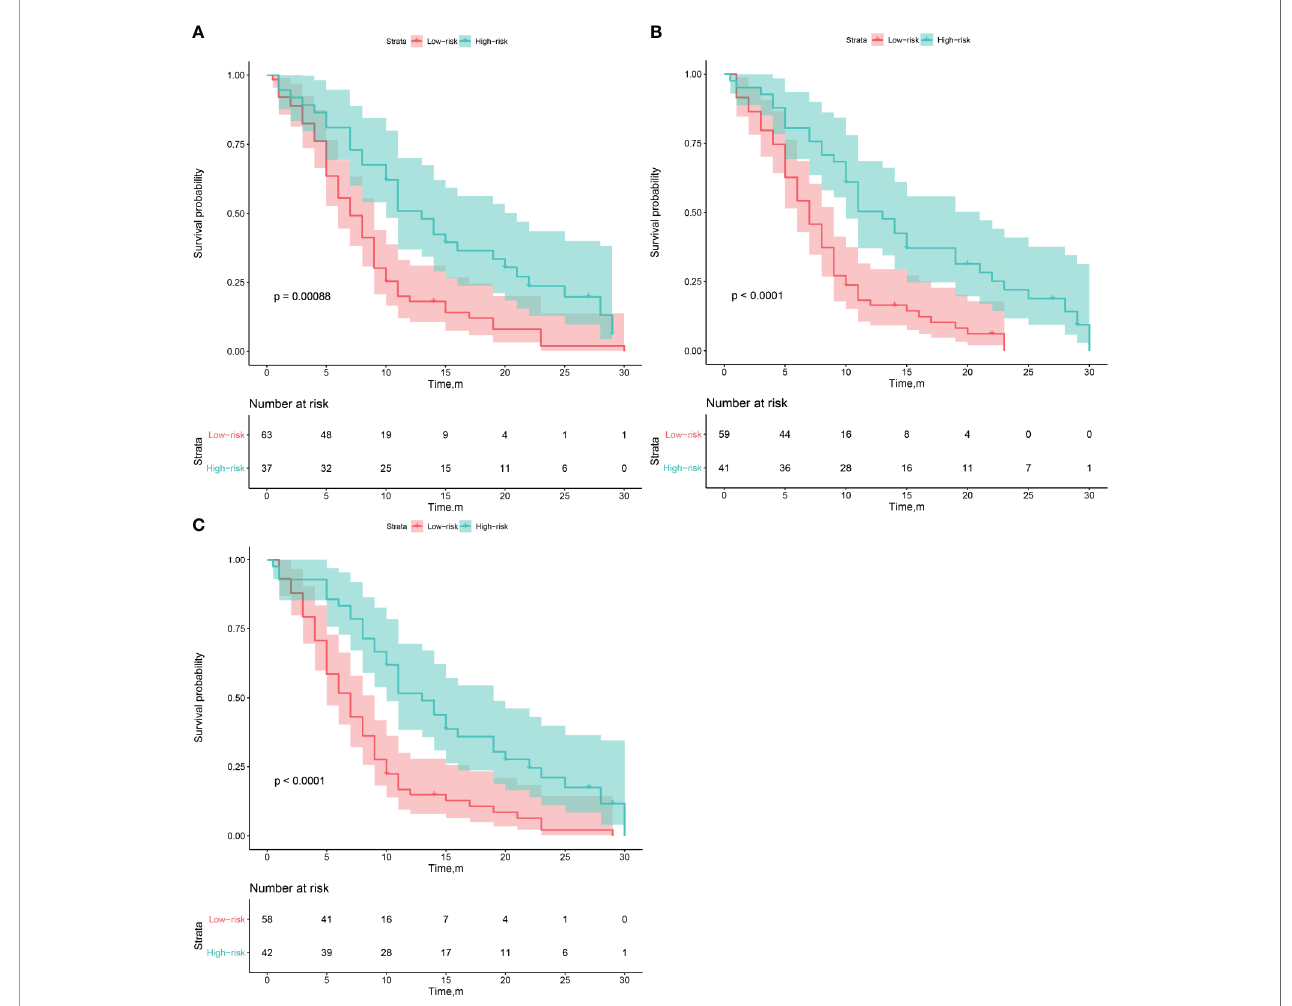
FIGURE 4 | Survival analysis of PFS in low and high risk patients in the validation group. (A – C) The CNN Scratch and clinical, CNN TL-BM and clinical, and CNN TL-EGFR and clinical model ’ s KM curves,